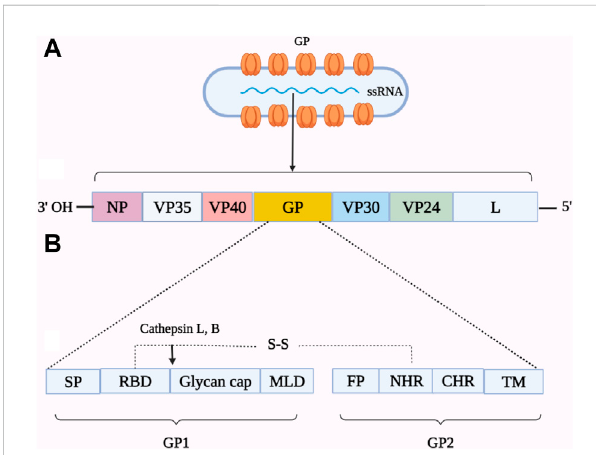
FIGURE 1 Schematic representation of the genome organization of Ebolavirus (EBOV) (A) and a linear view of the glycoprotein (GP) (B) . The single-stranded RNA (ssRNA) genome of EBOV is comprised of certain encoding protein genes. The viral proteins (VP), including NP (nucleoprotein) and VP24 (matrix protein), form the ribonucleoprotein complex. Other VP, such as VP40 (matrix protein), VP30 (transcriptional factor), VP35 (polymerase cofactor), and L (RNA polymerase), are involved in the structure of the virus or replication. The surface spikes on the virion are composed of a trimeric transmembrane GP that is comprised of GP1 and GP2 linked by a disul fi de bond. The GP1 subunit consists of a signal peptide (SP), a receptor-binding domain (RBD), a glycan cap, and a mucin-like domain (MLD). The GP2 subunit contains a transmembrane domain (TM) anchor to two heptad repeats, namely, N-terminal (NHR) and C-terminal (CHR) heptad repeats, and a membrane-proximal external region (not